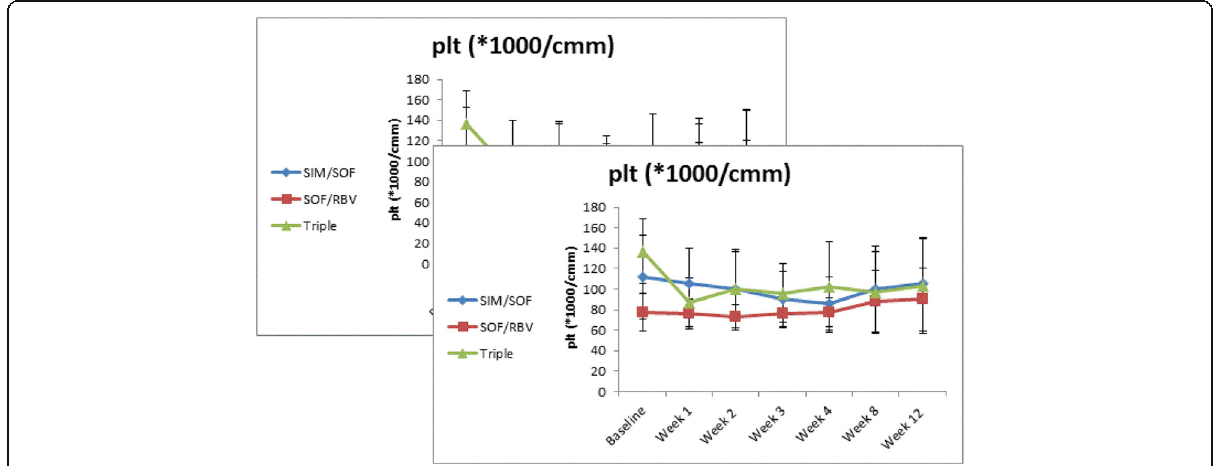
Fig. 1 Changes in mean platelet count during therapy